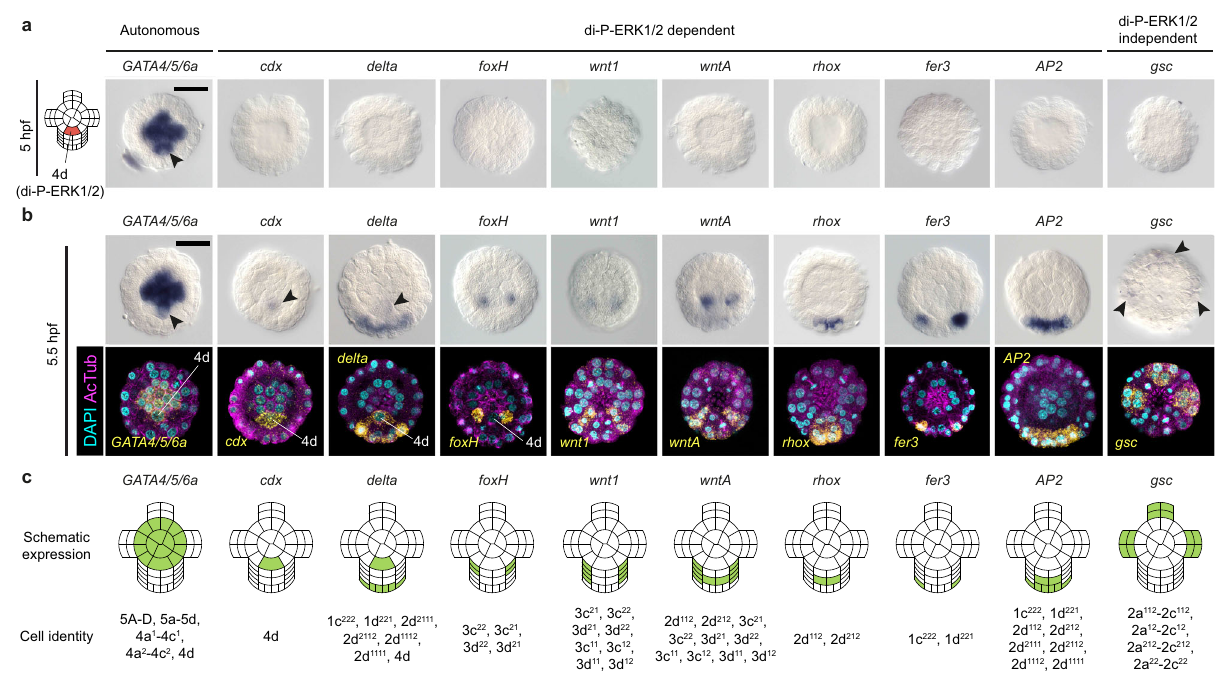
Fig. 5 ERK1/2 signalling speci fi es and patterns the D-quadrant. a , b Whole mount in situ hybridisation of a subset of genes (ERK1/2-dependent and independent) patterning the vegetal pole at 5- and 5.5-h post fertilisation (hpf) respectively. At 5 hpf ( a ), when the 4d is speci fi ed (left drawing) only the endodermal marker GATA4/5/6a is expressed (including in the 4d cell, arrowhead). At 5.5 hpf ( b ), cdx and delta become expressed in the 4d cell (arrowheads) and the C- and D-quadrant micromeres surrounding the 4d cell start expressing a range of genes involved in posterodorsal and mesodermal development ( foxH , wnt1 , wntA , rhox , fer3 and AP2 ). The anterior oral ectodermal gene gsc , which is not directly regulated by ERK1/2 activation, also starts to be expressed at this time point (arrowheads). In b , the upper raw are colorimetric in situ hybridisations and the lower row are z-stack projections of fl uorescent in situ hybridisations counterstained for nuclei (with DAPI) and cell borders (with Acetylated Tubulin immunohistochemistry). In a and b , all panels are vegetal views. Descriptions for a and b are based on at least ten embryos per stage, from a minimum of two biological replicates. c Schematic representation of the vegetal pole and micromeres of the C- and D-quadrant around the 4d blastomere depicting gene expression domains (in green) and inferred cell identities of the studied genes at 5.5 hpf. Scale bars are 50 μ m. Drawings are not to